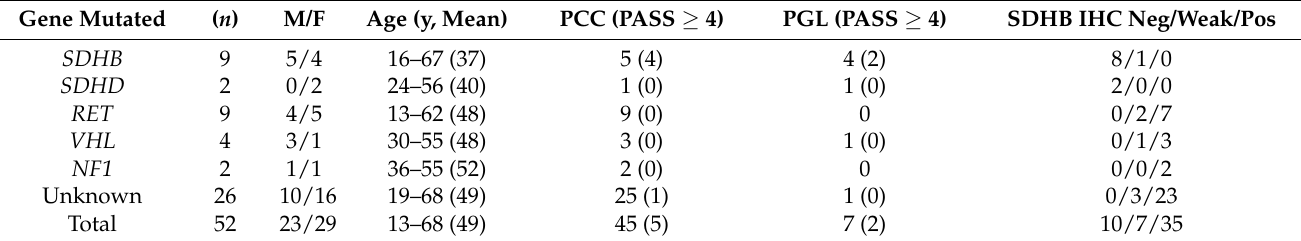
Table 1. Clinical and immunohistochemical data on 52 patients who underwent genetic analysis.